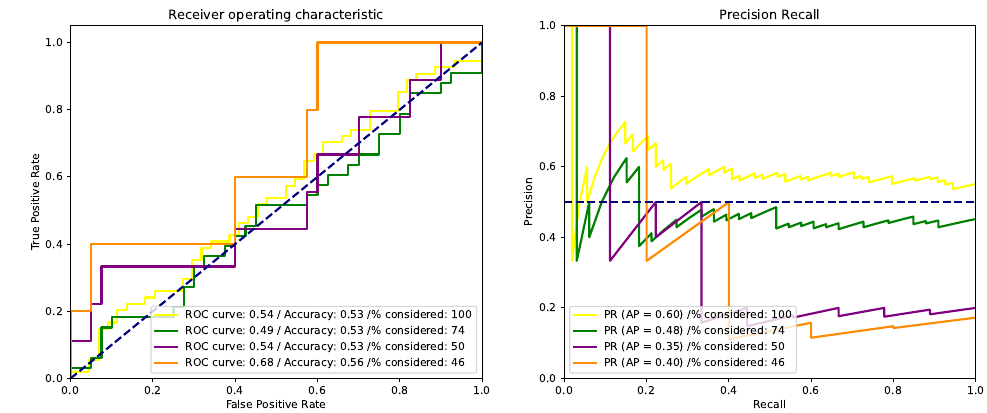
Figure A4. ROC and PR curves for the methylation percentage metric. T1wCE only. Table A3. Results of confidence metrics on the validation set. Tumor-centered, FLAIR only.